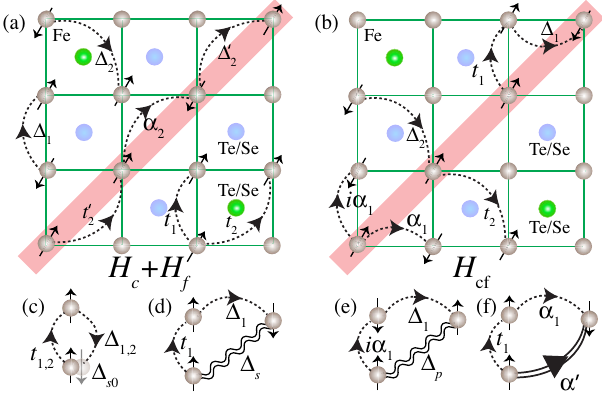
FIG. 3. Schematic illustration of the 2D Hamiltonian for Fe(Te,Se) and the leading dynamic processes generating the mixed-parity pairing along the RALD (highlighted in red). (a) Hopping and pairing parameters in the bulk ( H c ) and along the RALD ( H f ). (b) Coupling parameters between the bulk and the RALD ( H cf ). The second-order processes are depicted for generating on-site s -wave pairing (c), extended s -wave pairing (d), odd-parity p -wave pairing (e), and the induced Rashba coupling (f) along the